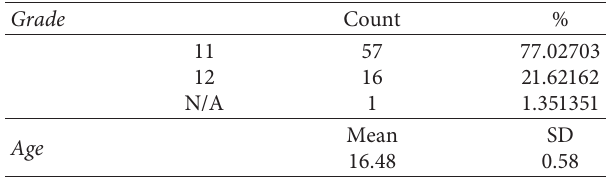
Table 1: Demographics (grade and age).